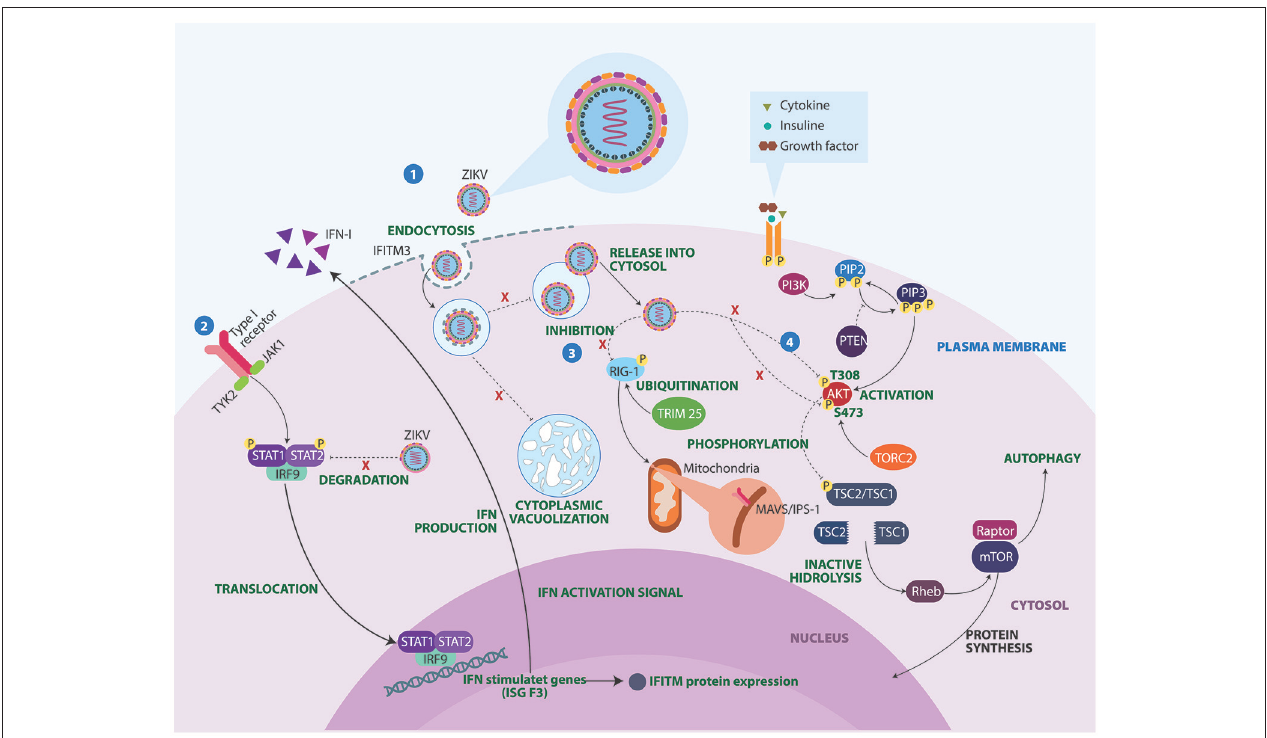
FIGURE 3 | Molecular mechanisms of ZIKV underlying the neuropathogenesis. 1. IFITM3 proteins confers immunity to the ZIKV. However, failure in the expression of this transmembrane protein allows viral replication, cell-fusion and massive vacuolization. 2. ZIKV protein NS5 binds and destroys STAT2 via proteosomal degradation, impeding interferon production. 3. Activated retinoic acid-inducible gene 1 (RIG-1) receptors recognize viral components and induce an antiviral immune response. However, ZIKV manages to inhibit these sensors, conferring resistance to IFN products. 4. Lastly, ZIKV proteins NS4A and NS4B interrupt phosphorylation of AKT at two sites T308 and S473. As a result, ZIKV infection turns out to be a substantial stressor for the Akt pathway, which could have important clinical implications in brain functioning and development. IFITM3, Interferon induced transmembrane protein 3; IFN, Interferon; IRF9, Interferon regulatory factor 9; ISG F3, Interferon-stimulated gene factor 3; JAK1, Janus kinase 1; MAVS, Mitochondrial antiviral-signaling protein; mTOR, Mammalian target of rapamycin; PI3K, Phosphoinositide 3-kinase; PIP2, Phosphatidylinositol 4,5-bisphosphate; PIP3, Phosphatidylinositol (3,4,5)-trisphosphate; PTEN, Phosphatase and tensin homolog; Rheb, Ras homolog enriched in brain; STAT, Signal transducer and activator of transcription; TORC2, Transducer of CREB protein 2; TRIM 25, Tripartite motif-containing protein 25; TSC, Tuberous sclerosis; TYK2, Tyrosine Kinase